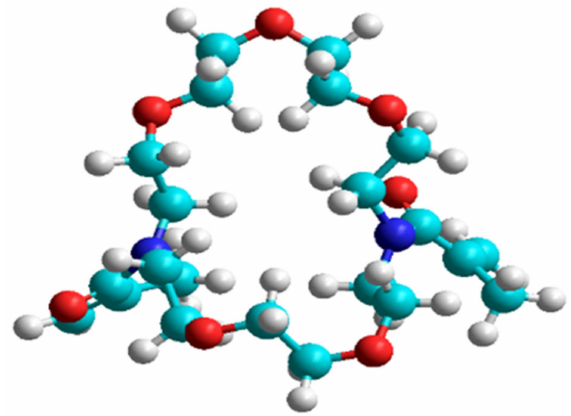
Figure 3. The optimized geometries of Kry23-DM cross-linker according to molecular mechanics (MM2)